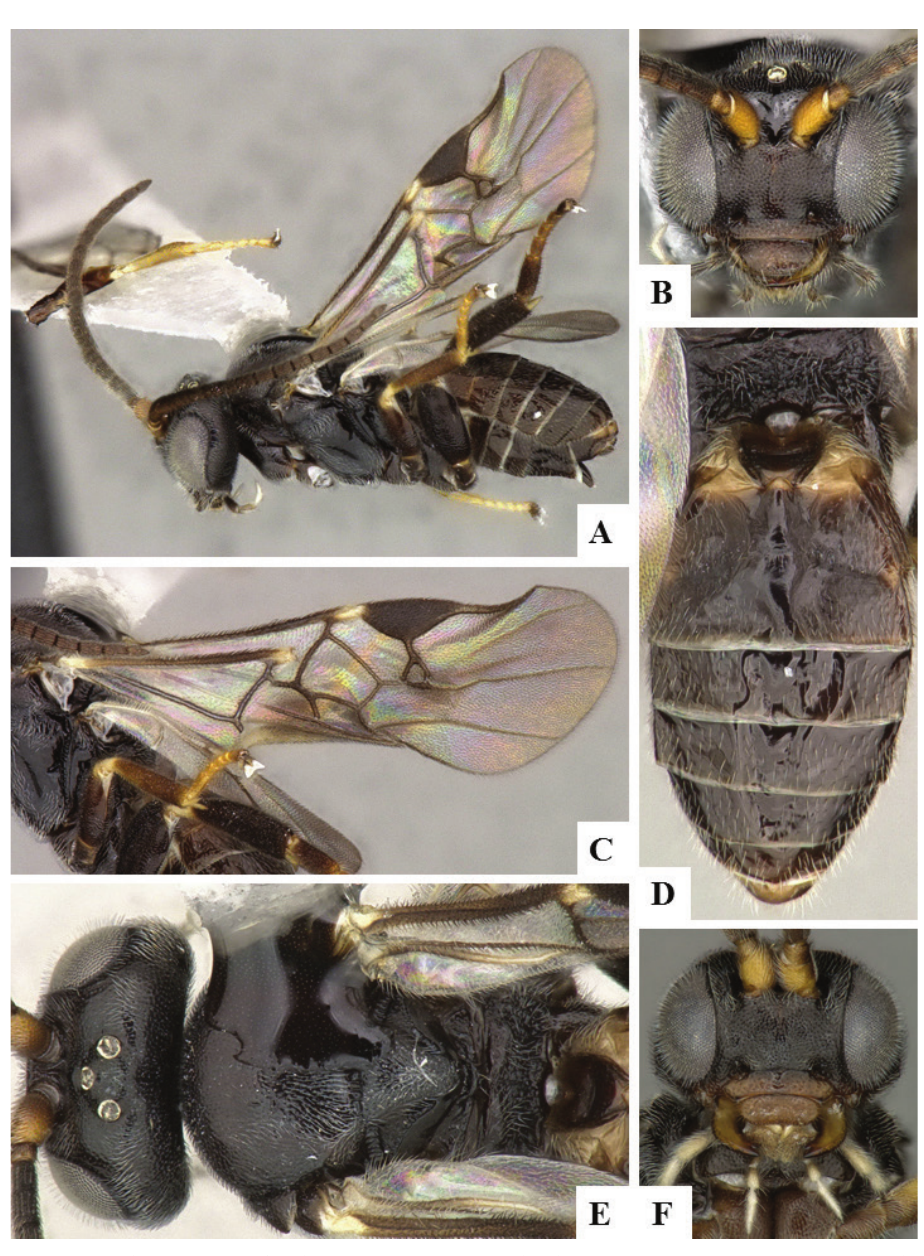
Figure 35. Silvaspinosus vespa female CNC644540 ( A–E ) and male CASENT8402171 ( F ) paratypes. A Hab- itus B Head frontal C Fore wing D Metasoma dorsal E Head and mesosoma, dorsal F Head frontal, male. (0.21); F3 L: 0.23 (0.21); F14 L: 0.15 (0.13); F15 L: 0.15 (0.13); Malar sulcus L: 0.01 (0.03); Mandible W: 0.21 (0.21); T1 L: 0.51 (0.38); T1 W at posterior margin: 0.10 (0.10); T1 maximum W: 0.28 (0.23); T2 W at anterior margin: 0.60 (0.49); T2 W